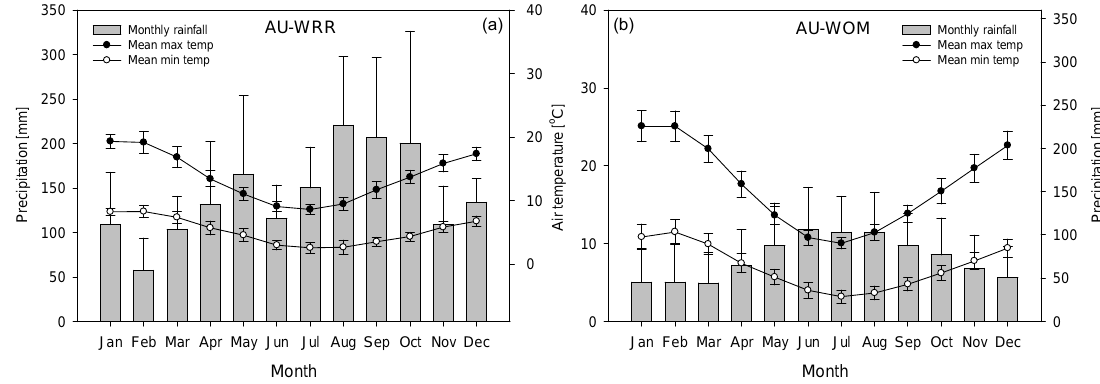
Figure 1. Climate at the investigated sites of (a) Warra Long-Term Ecological Research in Tasmania (AU-WRR) and (b) Wombat State Forest in Victoria (AU-WOM). Black circles represent monthly mean maximum air temperatures. White circles represent monthly mean minimum air temperatures. Grey bars represent monthly precipitation. Error bars represent ± 1SD. Data source: Bureau of Meteorology Australia, http://www.bom.gov.au (station numbers 097024 for AU-WRR and 088020 for AU-WOM).